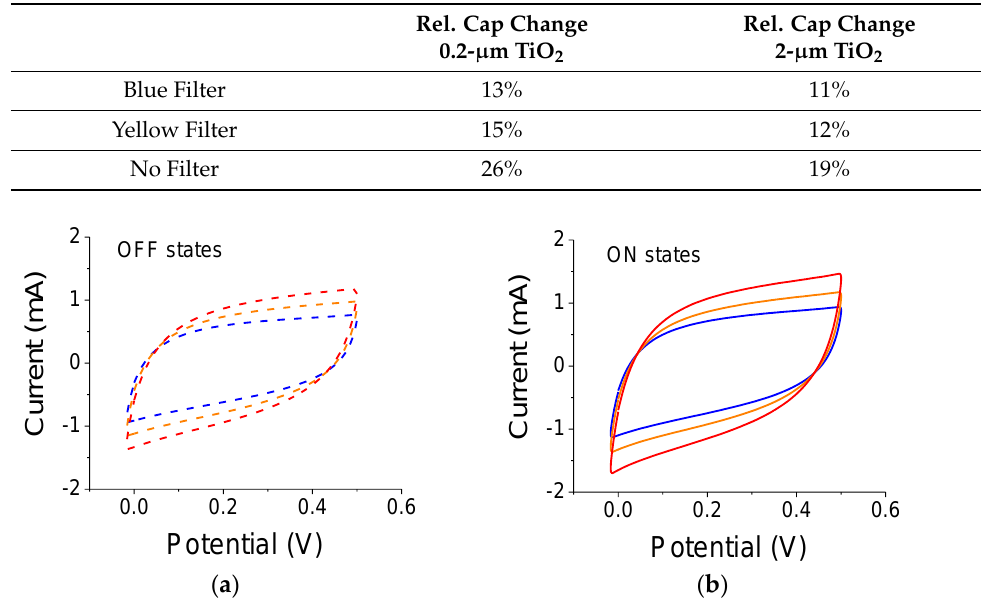
Figure 4. ( a ) Light OFF, C-V reference curves for 0.2 µm particles measured before each illumination by a 300 W white-light source. The colored dashed curves correspond to successive references for data taken with the blue, yellow, and no filter, respectively. ( b ) C-V curves for light ON cases; the blue, yellow, and red curves correspond to illumination with blue, yellow, and no filter, respectively. The results for samples illuminated by a 75 W white-light source are shown in Figure 5. Table 2. Relative capacitive change using C-V measurements in a 3-electrode setting when illumi- nated by a 300 W white-light source. lamp. The overall cell capacitance has increased for both the reference and light-exposed cases,